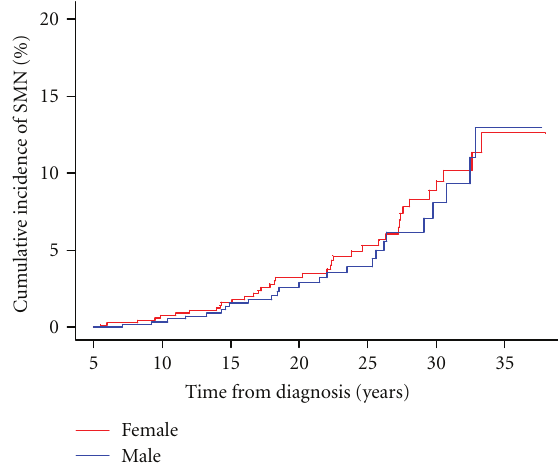
Figure 1: Cumulative incidence of SMN by